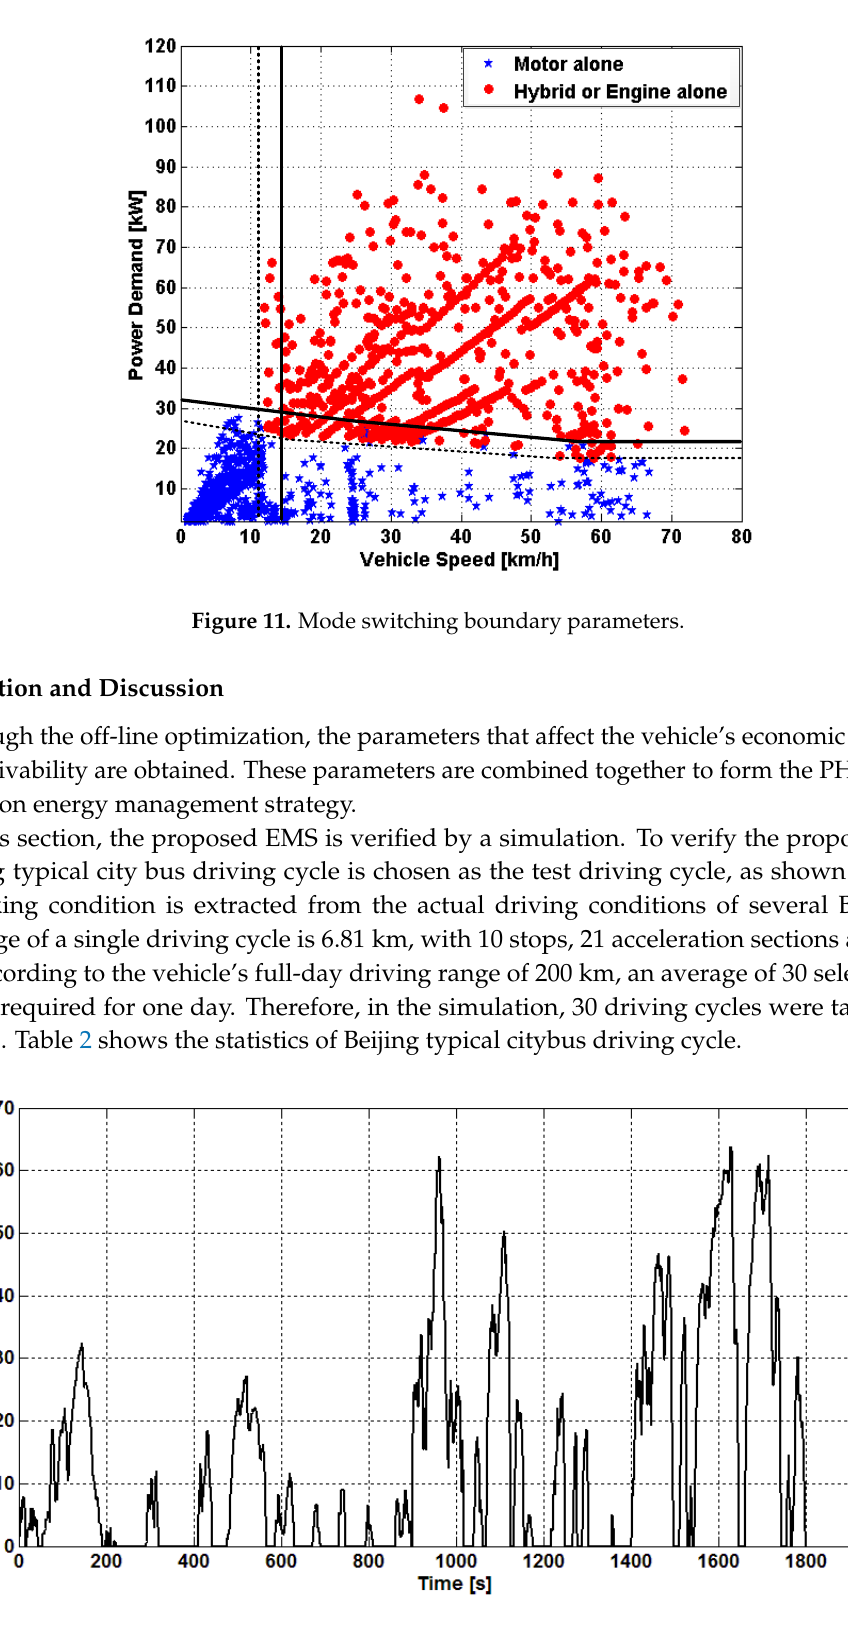
Figure 12. Beijing typical citybus driving cycle. Table 2. The statistics of the Beijing typical citybus driving cycle. Cycles